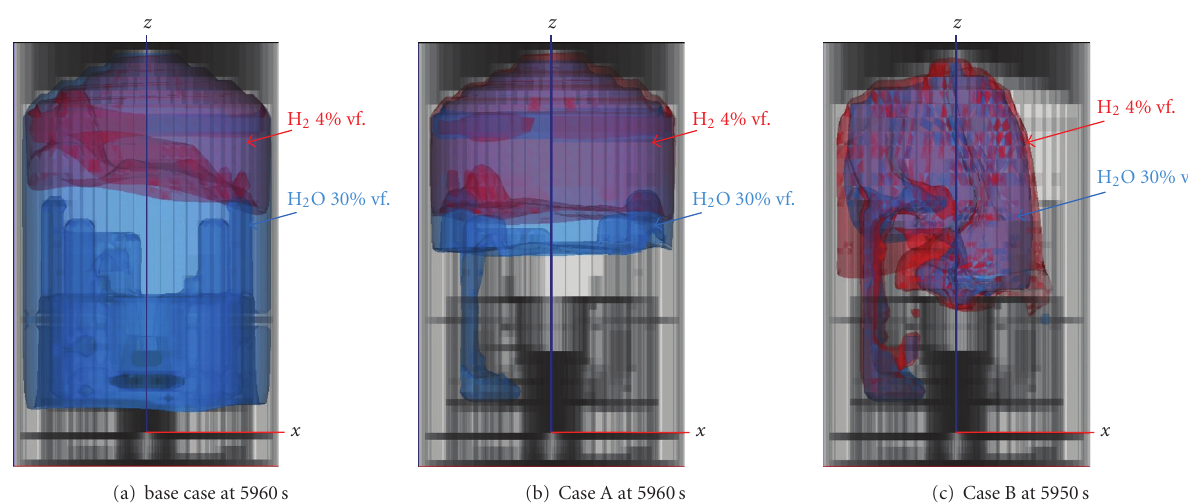
Figure 10: Hydrogen and steam clouds at the moment when hydrogen release reaches peak